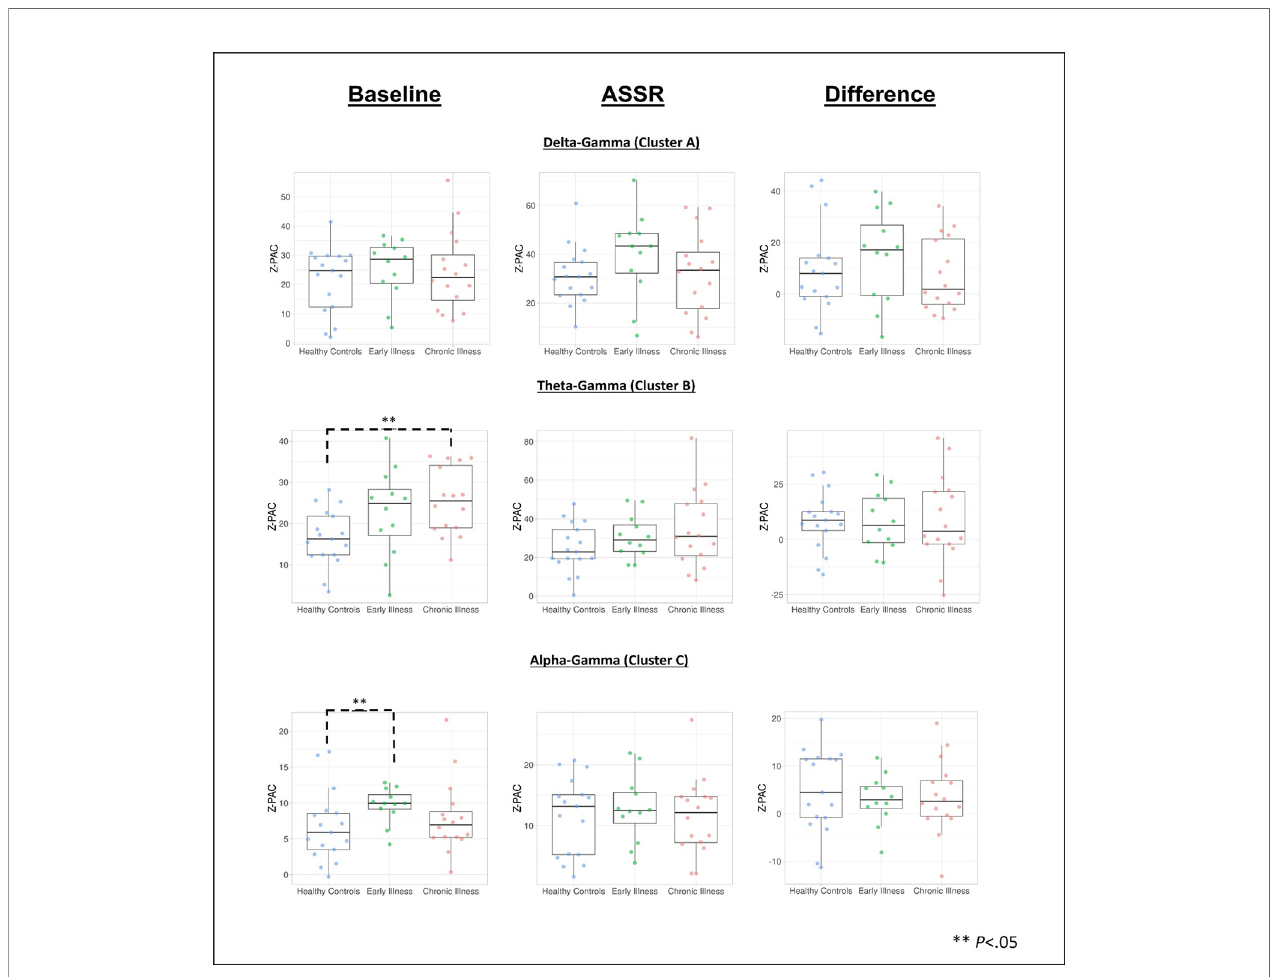
FIGURE 4 | Data visualization of cluster PAC information created using the PlotsOfData web app for data visualization (67). **Denotes signi fi cance at p <